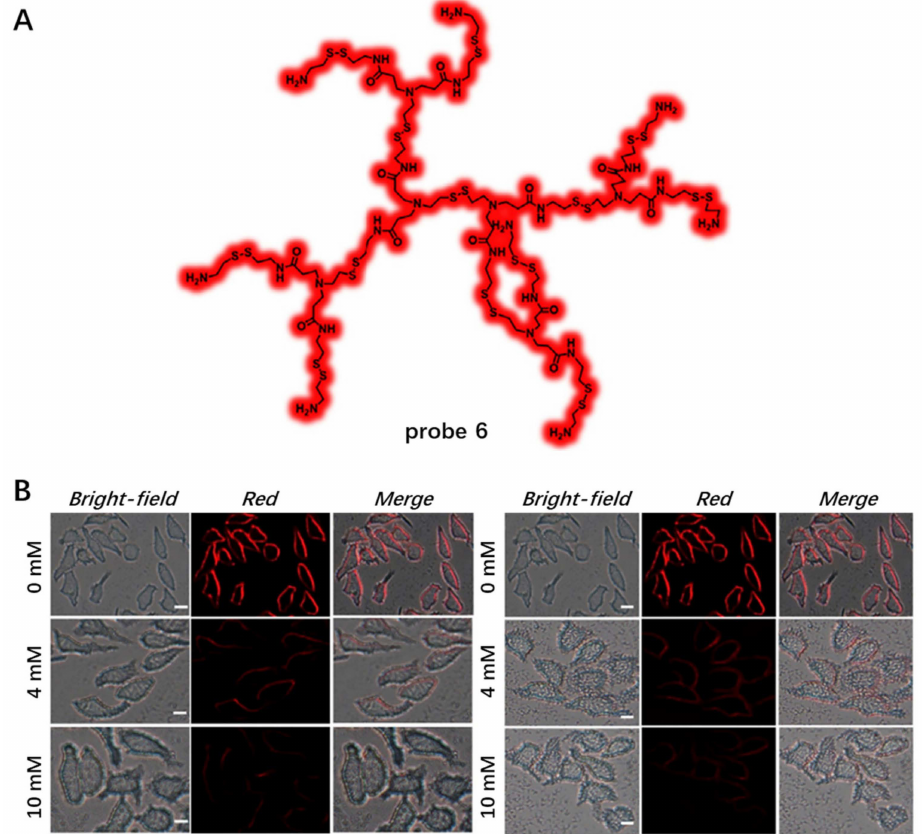
Figure 5. ( A ) Chemical structure of probe 6 . ( B ) CM imaging using probe 6 in the presence of DTT or GSH. Scale bar: 10 µ m. Copyright 2022 Elsevier